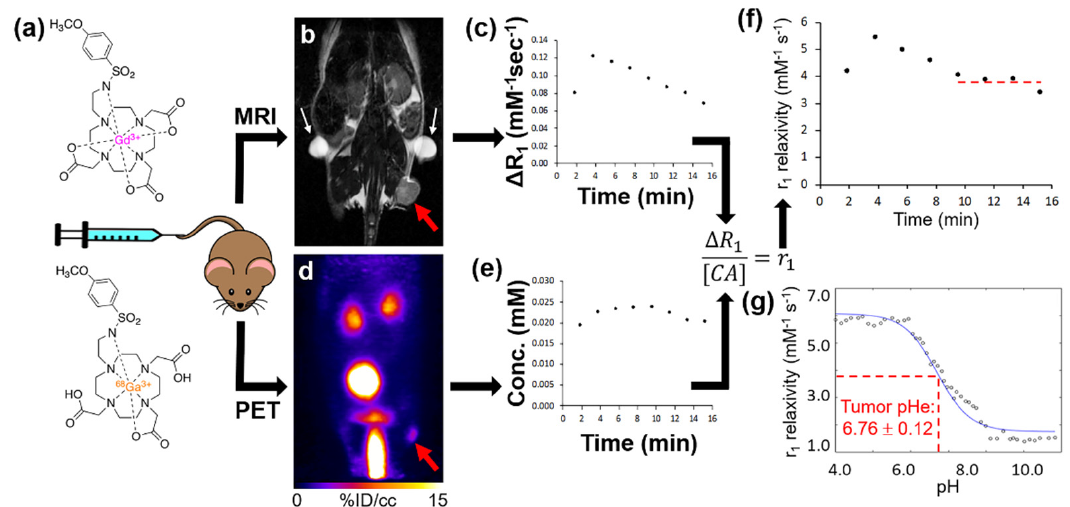
Figure 4. PET/MRI measures in vivo tumor pHe. ( a ) Simultaneous PET/MRI was performed with a single intravenous injection of the PET and MRI co-agents into a subcutaneous flank tumor model of MIA PaCa-2 pancreatic cancer. ( b ) Prior to injection, a baseline anatomical MR image and T 1 map were obtained. The tumor is highlighted with a red arrow. Fiducial markers are highlighted with white arrows. ( c ) A DCE MRI scan was then started, and after 1 min a known ratio of co-agents were simultaneously injected i.v. The change in relaxation rate ( Δ R 1 ) was determined from the MR images. ( d ) A dynamic PET scan was simultaneously obtained with the DCE MRI scan post-injection. ( e ) The dynamic concentration of the MRI co-agent was determined from the PET images via the known injected ratio of the two agents. ( f ) The Δ R 1 and concentration values were used to calculate r 1 relaxivities in two-minute time frames during the dynamic PET/MRI scan. ( g ) Once the curve